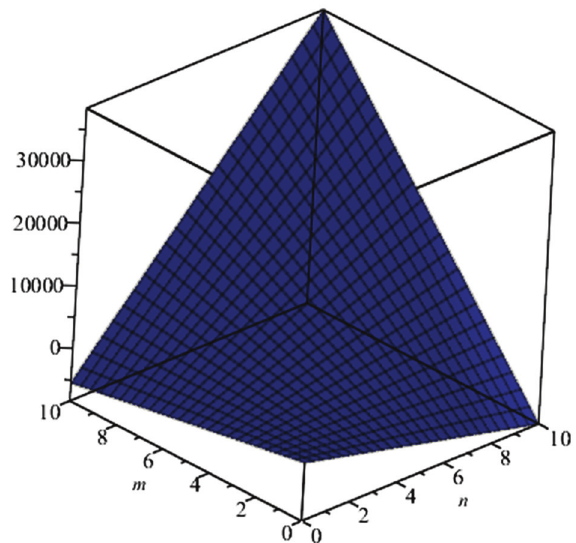
Figure 5: 3D plot of ZC P